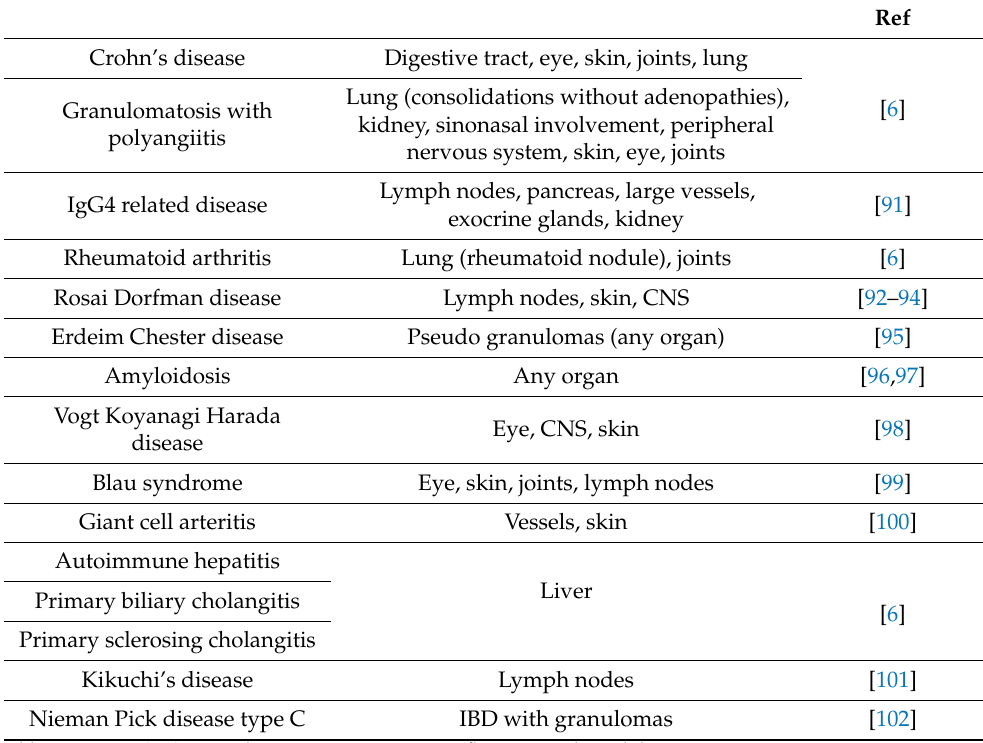
Table 2. Auto inflammatory, autoimmune and systemic conditions mimicking